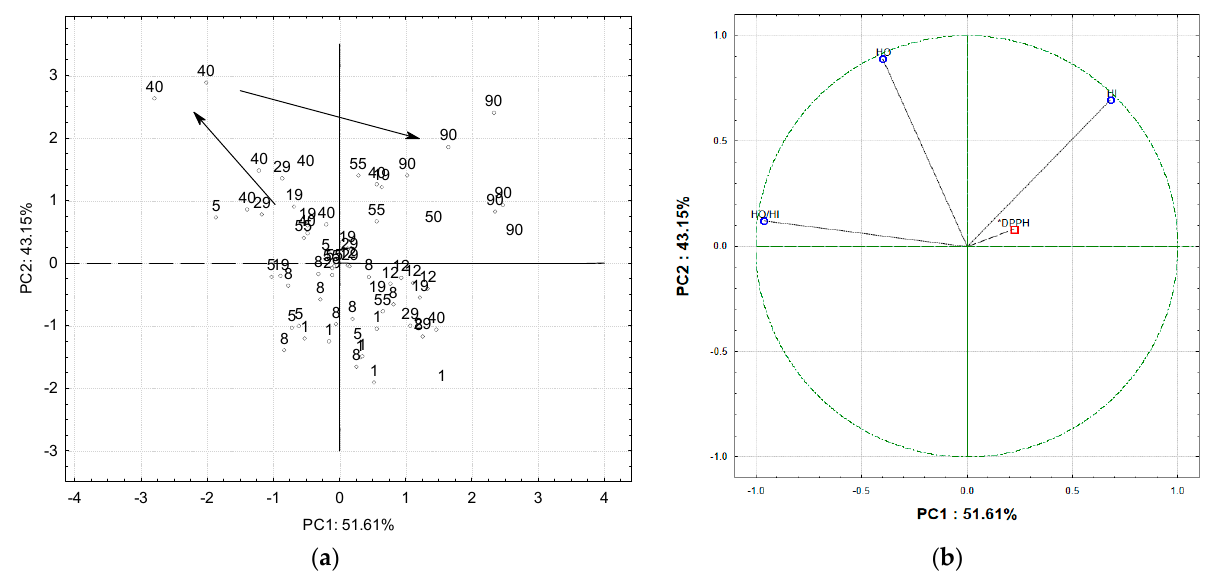
Figure 6. HI, HO, ratio HO/HI, and antioxidant activity in ASN profile. Two principal components (PC1 and PC2) are observed in PCA plots. ( a ) Factorial map obtained by principal components analyses (PCA) all in samples obtained by controlled ripening system. Arrows show the trend followed throughout the ripening process. ( b ) Factor loading plots (PC1 and PC2). Samples code represents the ripening day.